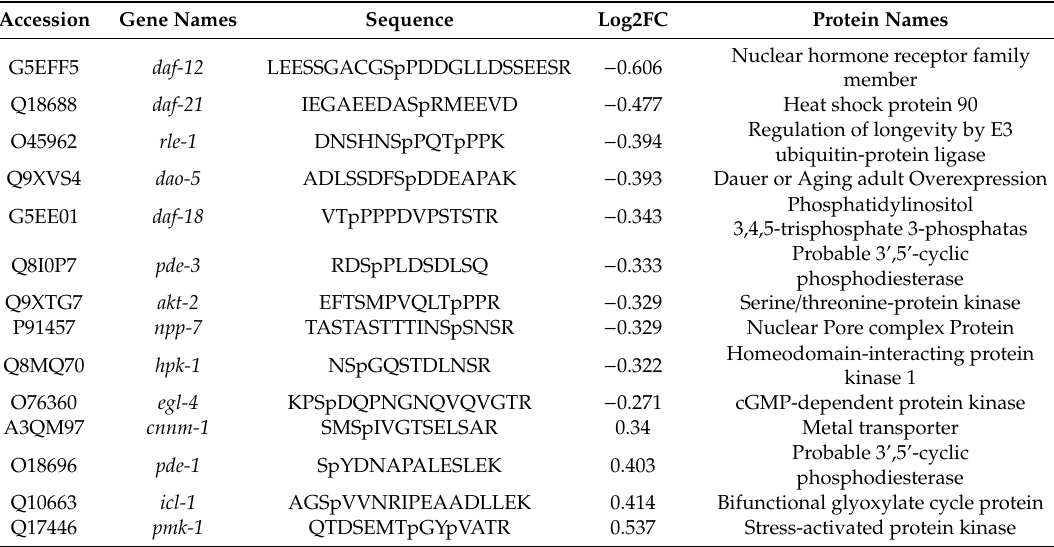
Table 2. The aging-related phosphoproteins in C. elegans at high